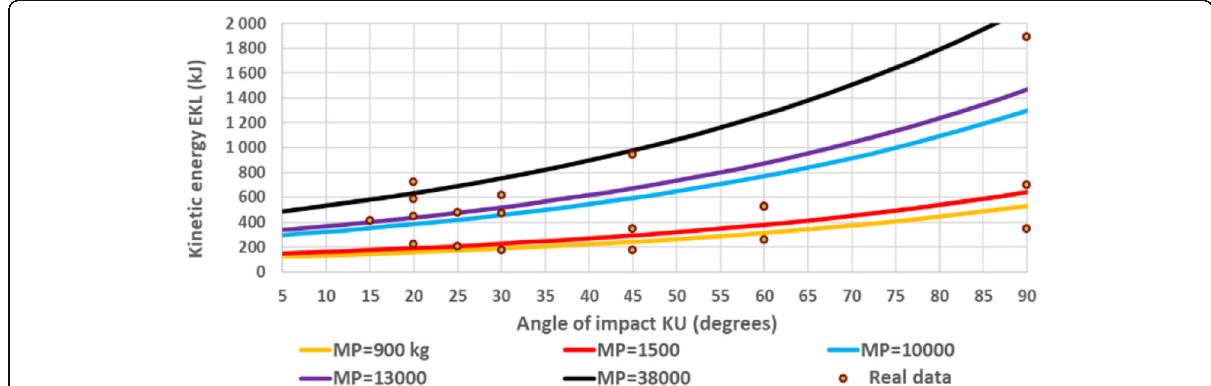
Fig. 7 Relationship between lateral kinetic energy EKL of a vehicle hitting a barrier and vehicle mass MP and angle of impact KU overlaid with the results of simulation and site